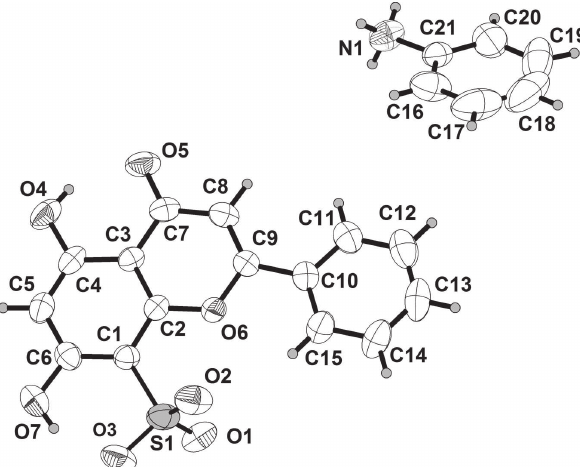
Table 1: Data collection and handling.